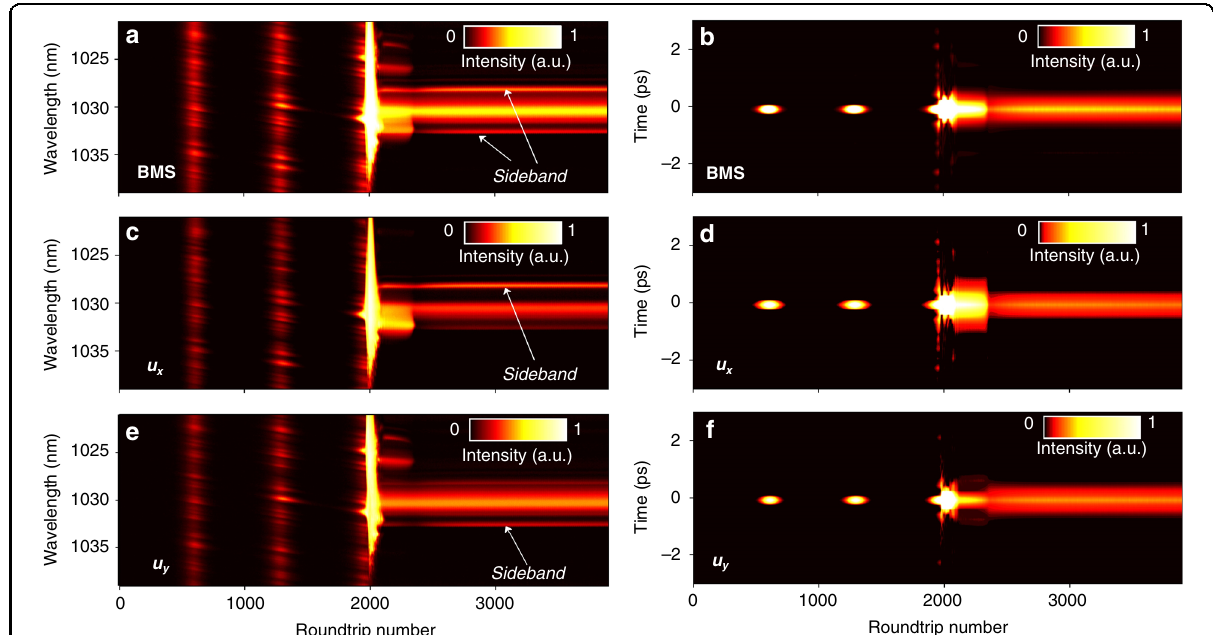
Fig. 5 Buildup processes of BMS measured by dispersive Fourier transform technique. Spectral and fi eld autocorrelation evolutions of ( a , b ) BMS, ( c , d ) u x component, and ( e , f ) u y